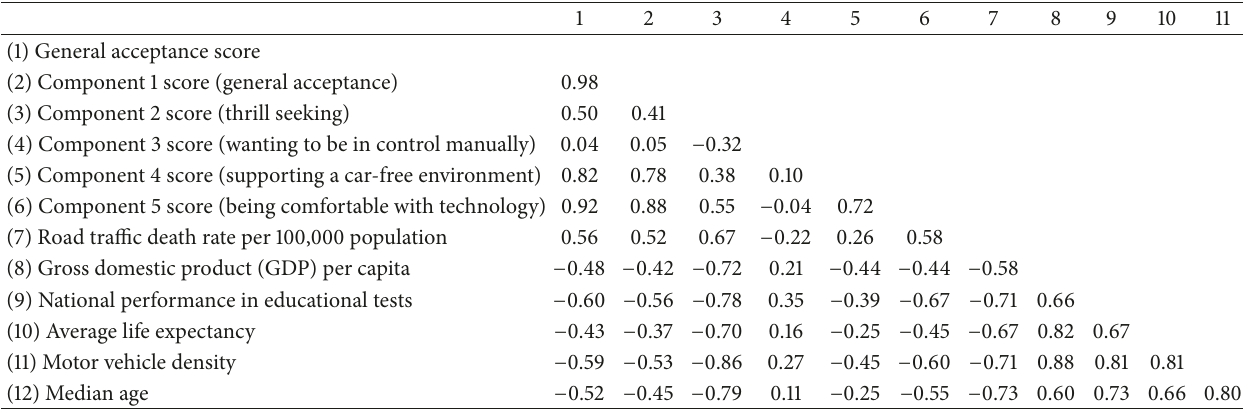
Table 4: Spearman correlation matrix at the national level ( 𝑛 = 43